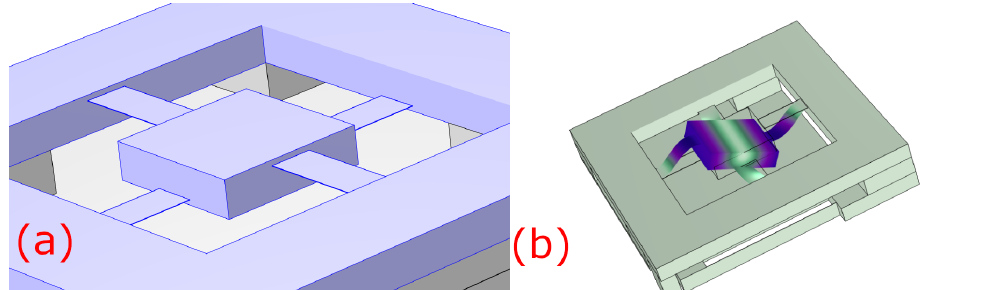
Figure 16. ( a ) A close-up of the z -axis test mass and its flexures. Note that the flexures are not at the midpoint of the wafer but have different offsets to increase the stiffnesses and frequencies of tip-tilt modes. ( b ) The tip-tilt mode of the z -axis resonator as seen from the underside of the three-axis resonator. The colors indicate the total displacement, with light green being the stationary and purple being the largest